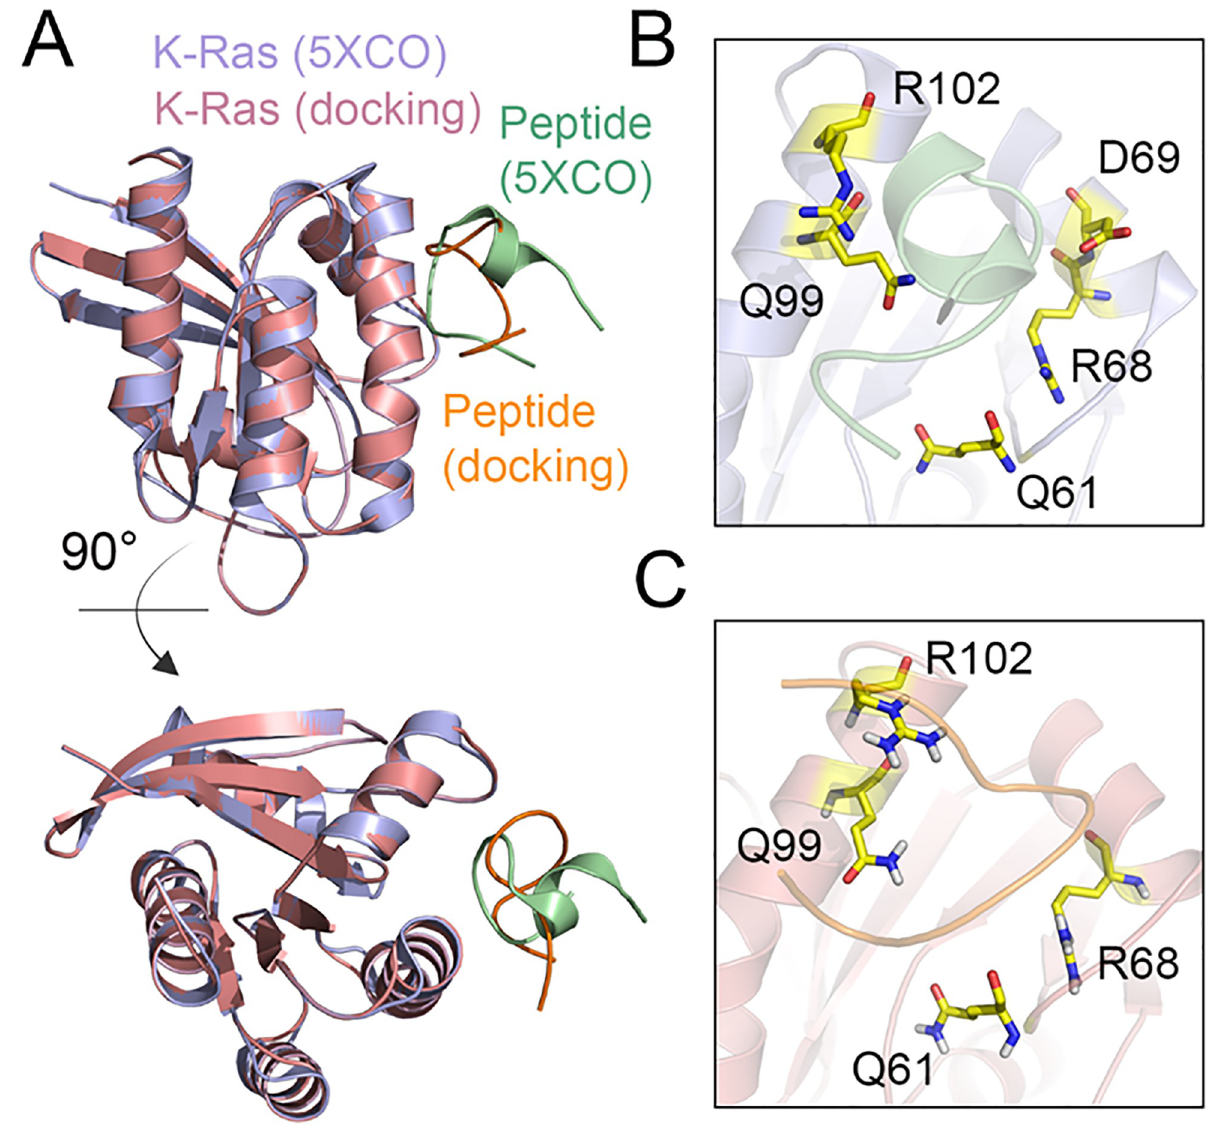
Fig 3. Validation of molecular docking method. ( A ) Structural alignment of the K-Ras G12D -peptide complex determined by X-ray crystallography (ID: 5XCO) and the docking model. Close-up view of the binding interface between K-Ras G12D and inhibitory peptide in the ( B ) crystallography and ( C ) docking studies. The residues of K-Ras G12D forming H-bond interactions with the peptide are shown in yellow.